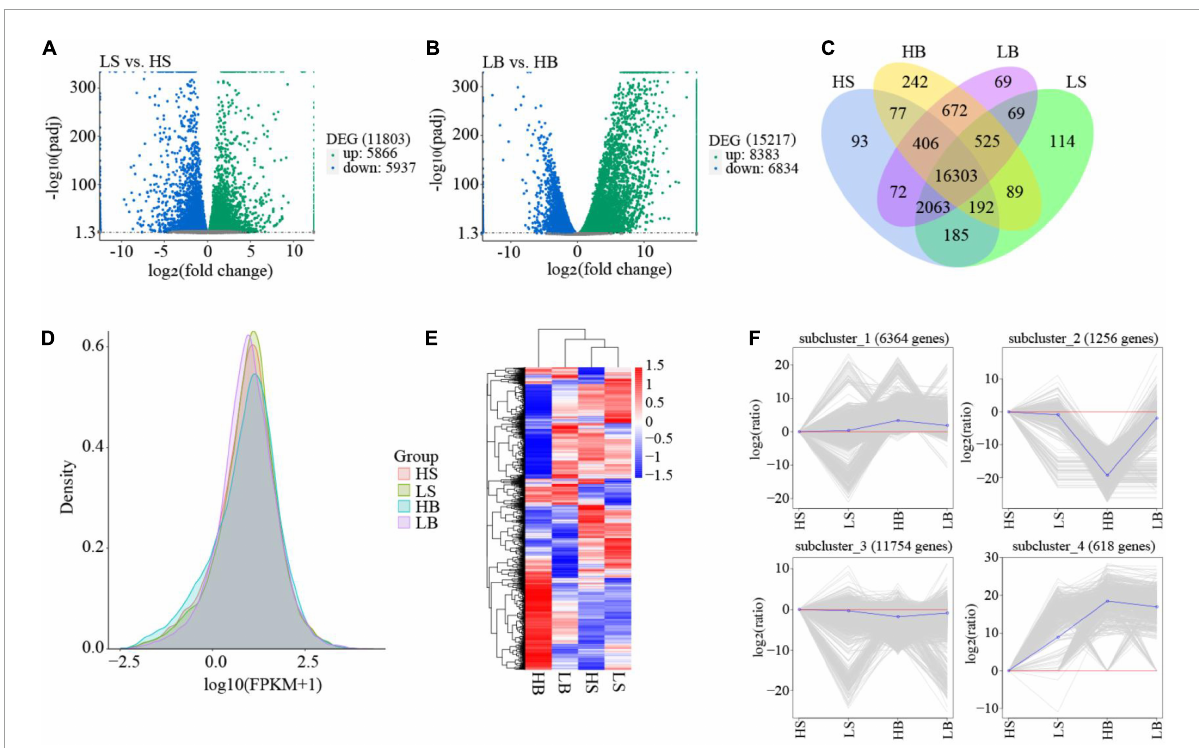
FIGURE5 Overview of the RNA-seq data analysis. (A) The Volcano Plot of H. ammodendron . The x -axis represents the fold change of gene expression in different samples; the y -axis represents the statistical significance of the difference in gene expression; and the genes with significant differential expression are represented by green dots (up-regulated) and blue dots (down-regulated). (B) The Volcano Plot of H. persicum. The x -axis represents the fold change of gene expression in different samples; the y -axis represents the statistical significance of the difference in gene expression; and the genes with significant differential expression are represented by green dots (up-regulated) and blue dots (down-regulated). (C) Venn diagram of all samples of H. ammodendron and H. persicum ; (D) FPKM density distribution; (E) DEG hierarchical clustering diagram of all samples; and (F) K-means clustering of gene expression trends. The gray line in each subgraph represents the relative expression of genes in a cluster under different experimental conditions (based on the expression of the first sample, i.e., shown by the red line), and the blue line represents the average relative expression of all genes in the cluster under different experimental conditions. LS and LB, respectively, represent H. ammodendron and H. persicum in an arid environment; HS and HB denote H. ammodendron and H. persicum , respectively, under a humid